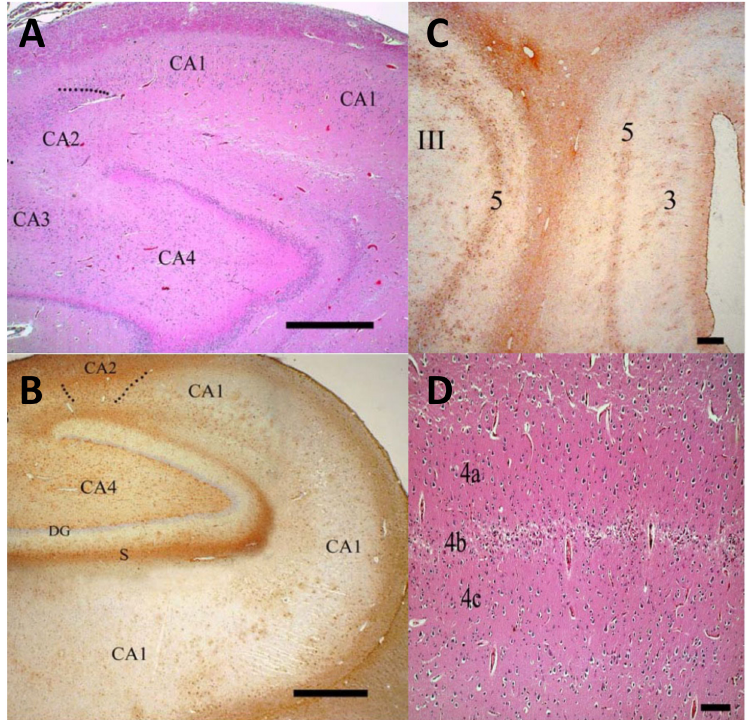
Figure 1. Regions affected in Gaucher disease (GD) include hippocampal regions CA2–CA4 and cortical layers. ( A ) Neuronal loss and astrogliosis observed in an autopsy of infant with GD2 case demonstrating astrogliosis in hippocampal regions CA2–CA4 with relative sparing of CA1 (H&E, 40 × magnification). ( B ) Mild astrogliosis in GD1 detected by GFAP staining, without neuronal loss. (GFAP immunoperoxidase, 40 × magnification). ( C ) Astrogliosis in GD1 shown by GFAF staining in cerebral cortical layer 5 (GFAP immunoperoxidase, 40 × magnification). ( D ) Calcarine cortex in an infant with GD2 demonstrating neuronal loss and astrogliosis in layer 4b, sparing layer 4a and 4c (H&E, 40 × magnification). Scale bars: ( A ) 1 mm; ( B ) 1 mm: ( C ) 250 µ m; ( D ) 100 µ m. Adopted